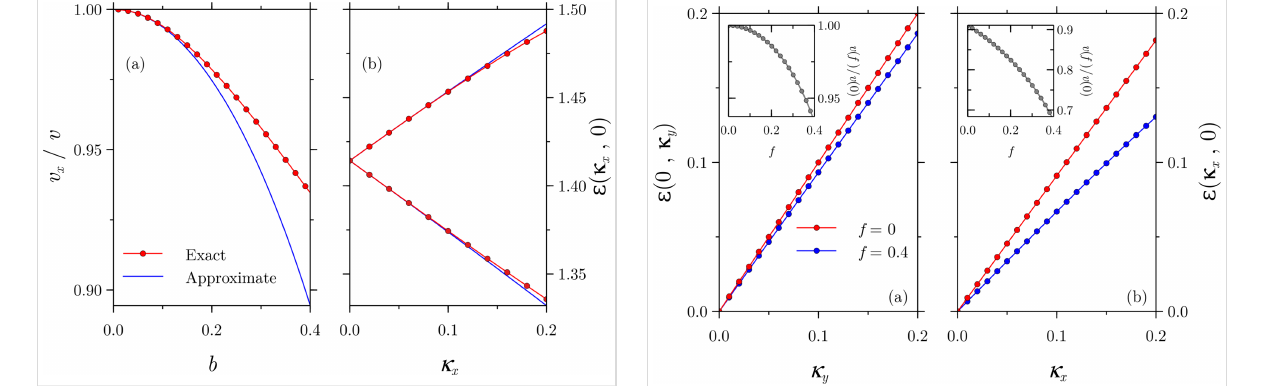
Figure 4: The additional effect of the electric field leads to a further reduction of the Fermi velocity in the x -direction and to a reduction along the y -direction as well. The Dirac point, however, remains robust. The insets show the Fermi velocity reduction as a function the electric field for a fixed magnetic field of b = 0.5. energy will be from the discussion above. However, as we turn on the electric field, a splitting similar to the one we had with κ x begins to develop. This splitting increases with electric field, up to a point where it starts decreasing again as f approaches b . In the limiting case where f → b , the splitting goes to zero, as we show in Figure 5 for b = 0.5.